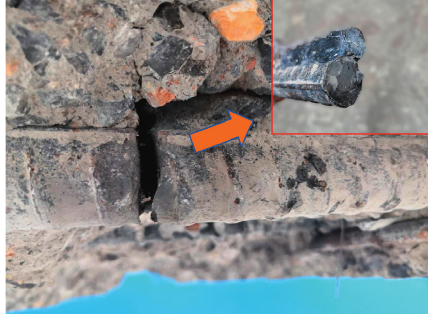
Figure 10: Fatigue fracture of steel bar.